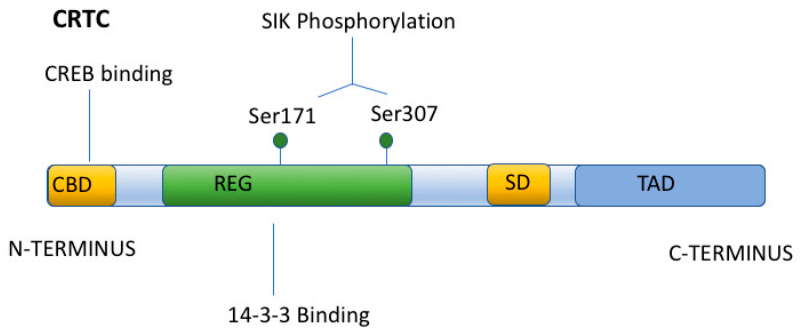
Figure 4. Structure of CRTC. CRTC has an amino terminal CREB binding domain (CBD), a Regulatory Domain (REG) which can be phosphorylated at two sites (Ser171 and Ser307) by SIK1, a splicing domain (SD), and a carboxy terminal Trans Activation Domain (TAD).